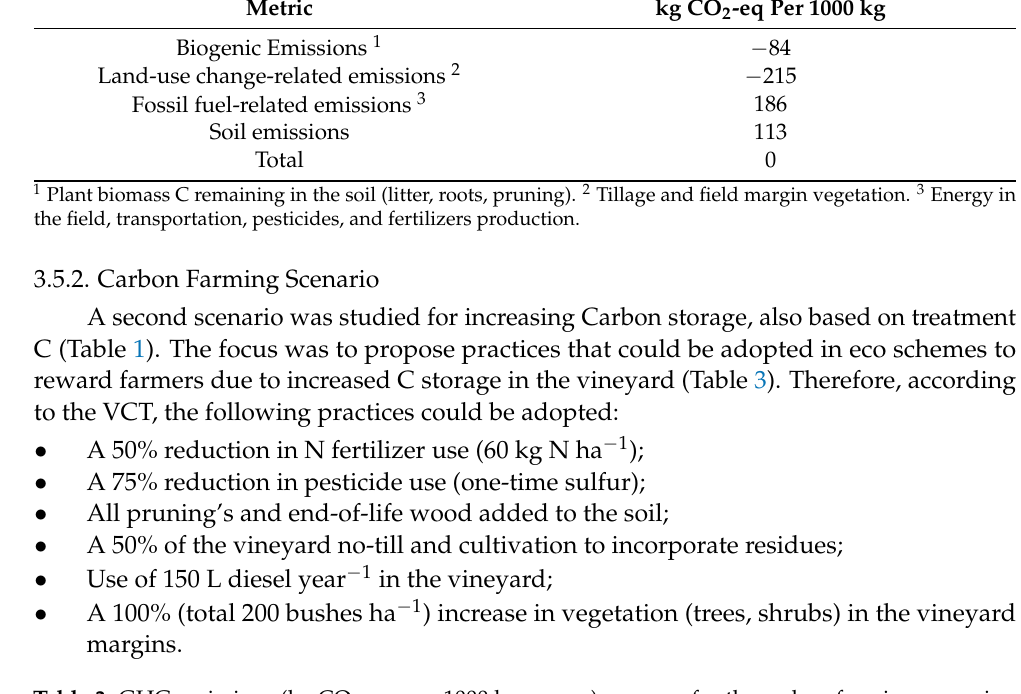
Table 3. GHG emissions (kg CO 2 − eq per 1000 kg grapes) per year for the carbon farming scenario.